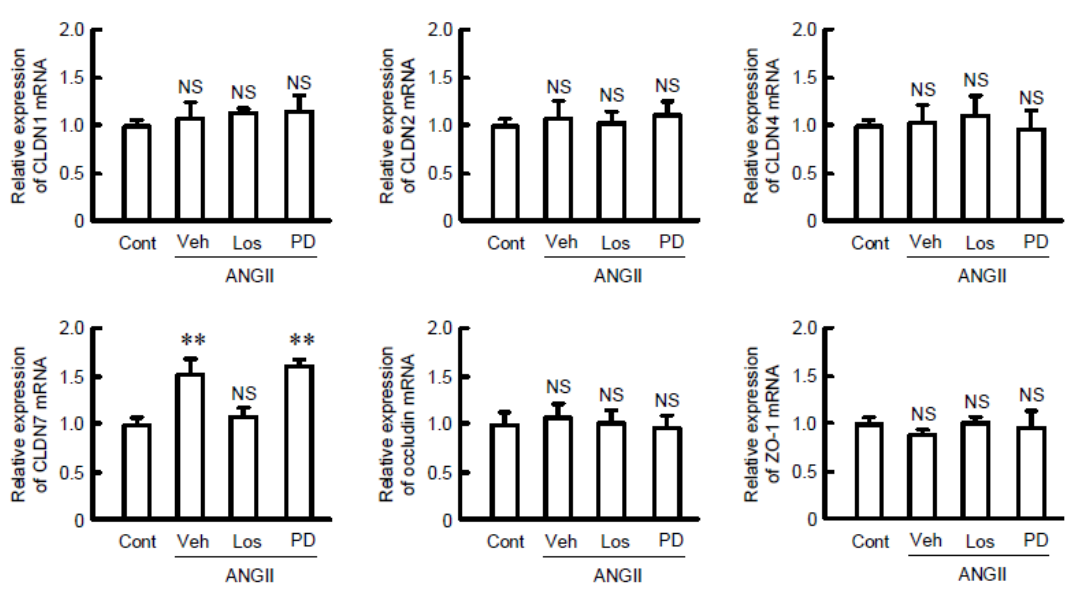
Figure 3. Effect of ANGII and receptor antagonists on expression of tight junctional proteins. Cells were treated with 10 µM ANGII for 6 h in the presence and absence of 10 µM losartan (Los) or 10 µM PD123319 (PD). After isolation of total RNA, RT-PCR was performed using primer pairs of mouse CLDN1, CLDN2, CLDN4, CLDN7, occludin, zonula occludens (ZO)-1, and β-actin. The contents of these transporters were represented relative to the values of β-actin. n = 3–4. ** p < 0.01 significantly different from control (Cont). NS p > 0.05 not significantly different.